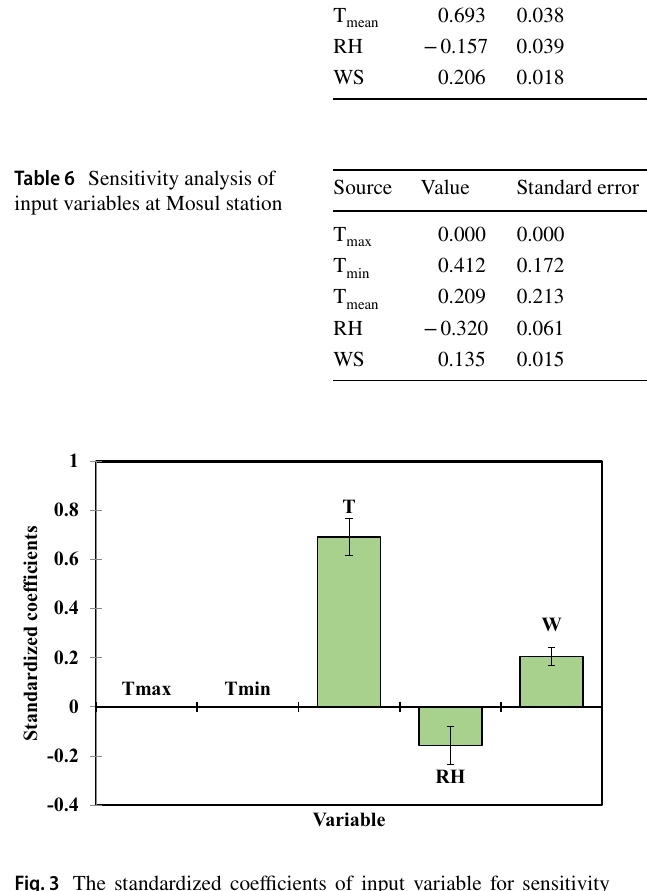
Fig. 3 The standardized coefficients of input variable for sensitivity analysis at Baghdad station for evaporation